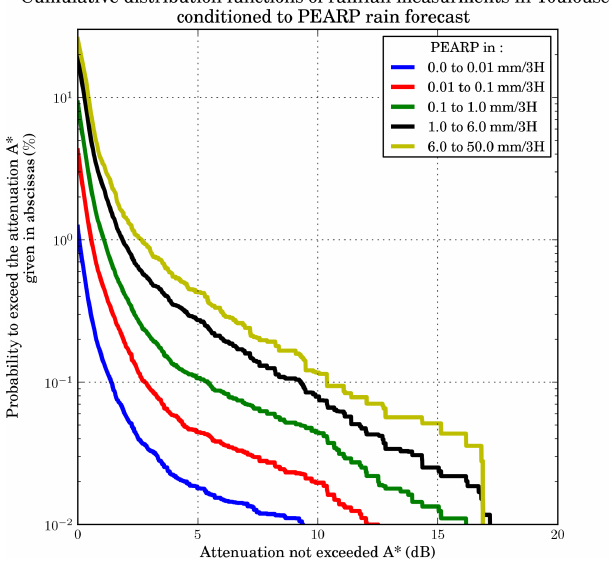
Figure 3. Probability of exceeding the attenuation threshold given in abscissas based on data recorded in 2014 and 2015 in Toulouse,